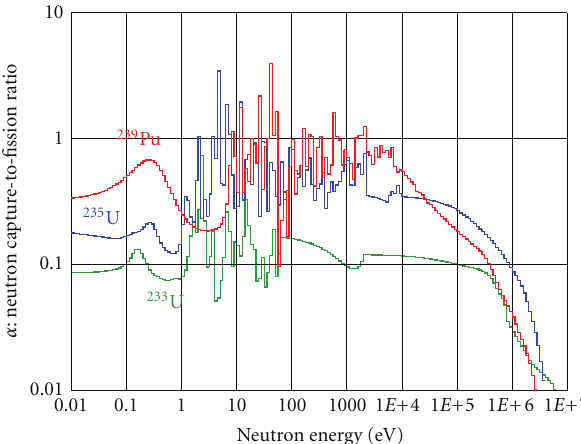
Figure 7: Ratios of capture-to-fission cross-sections for 239 Pu, 233 U, and 235